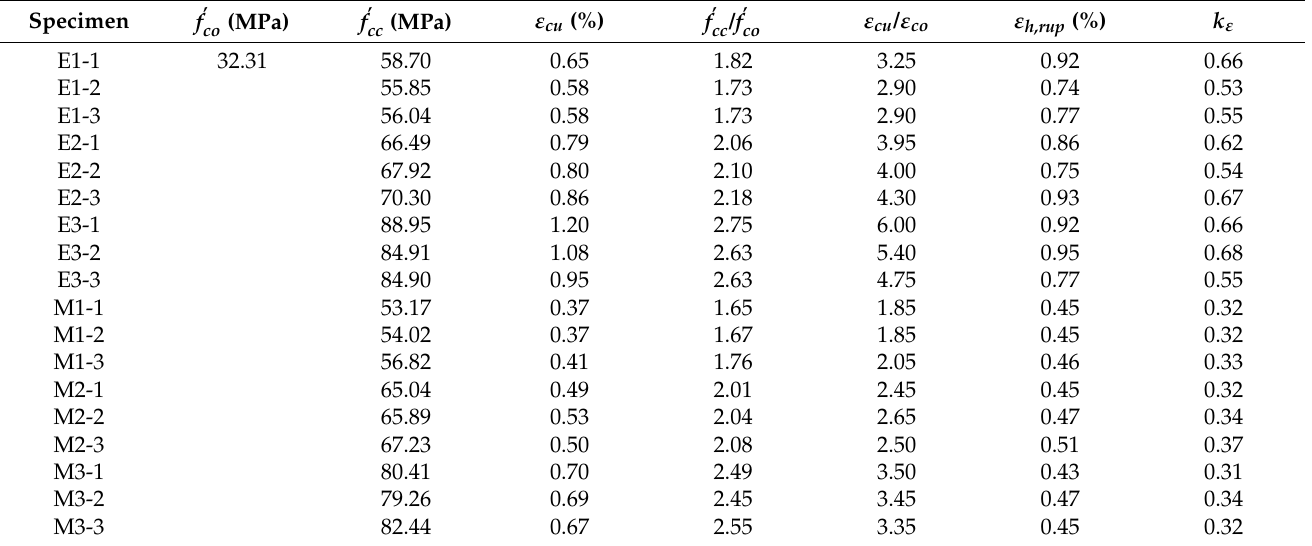
Table 4. The test results of the FRP- and FRiP-confined